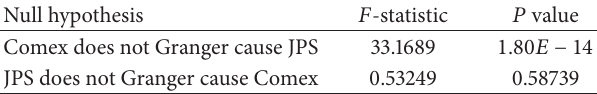
Table 2: The result of the Granger causality test.